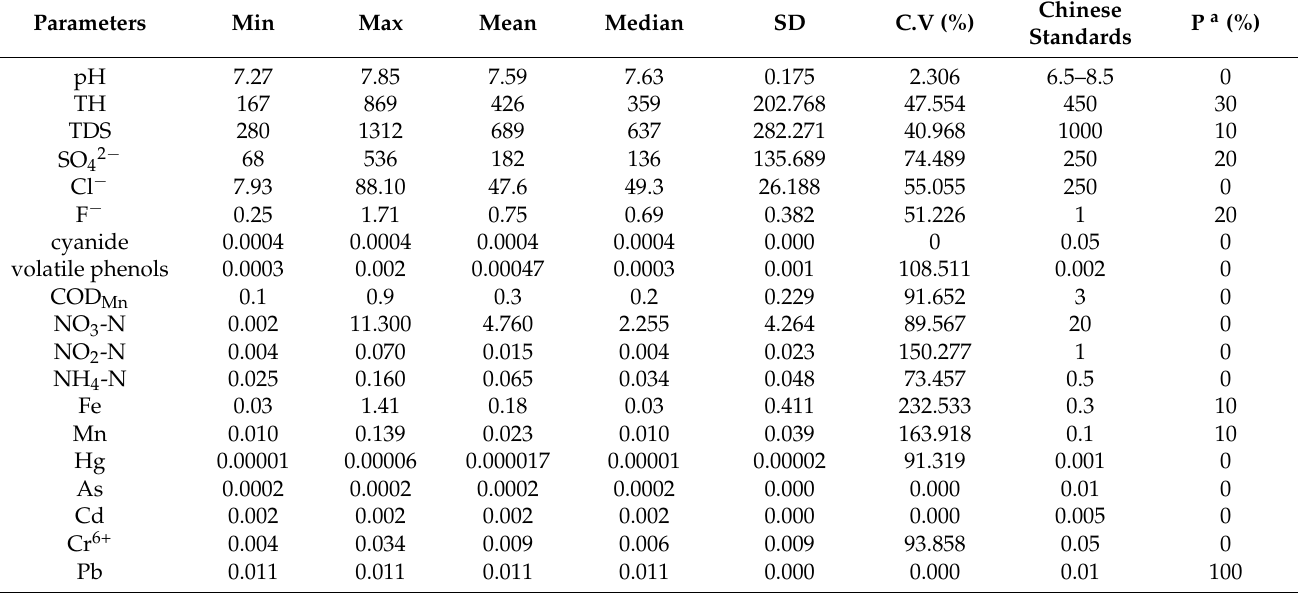
Table 3. Statistical analysis results for hydrochemical parameters of